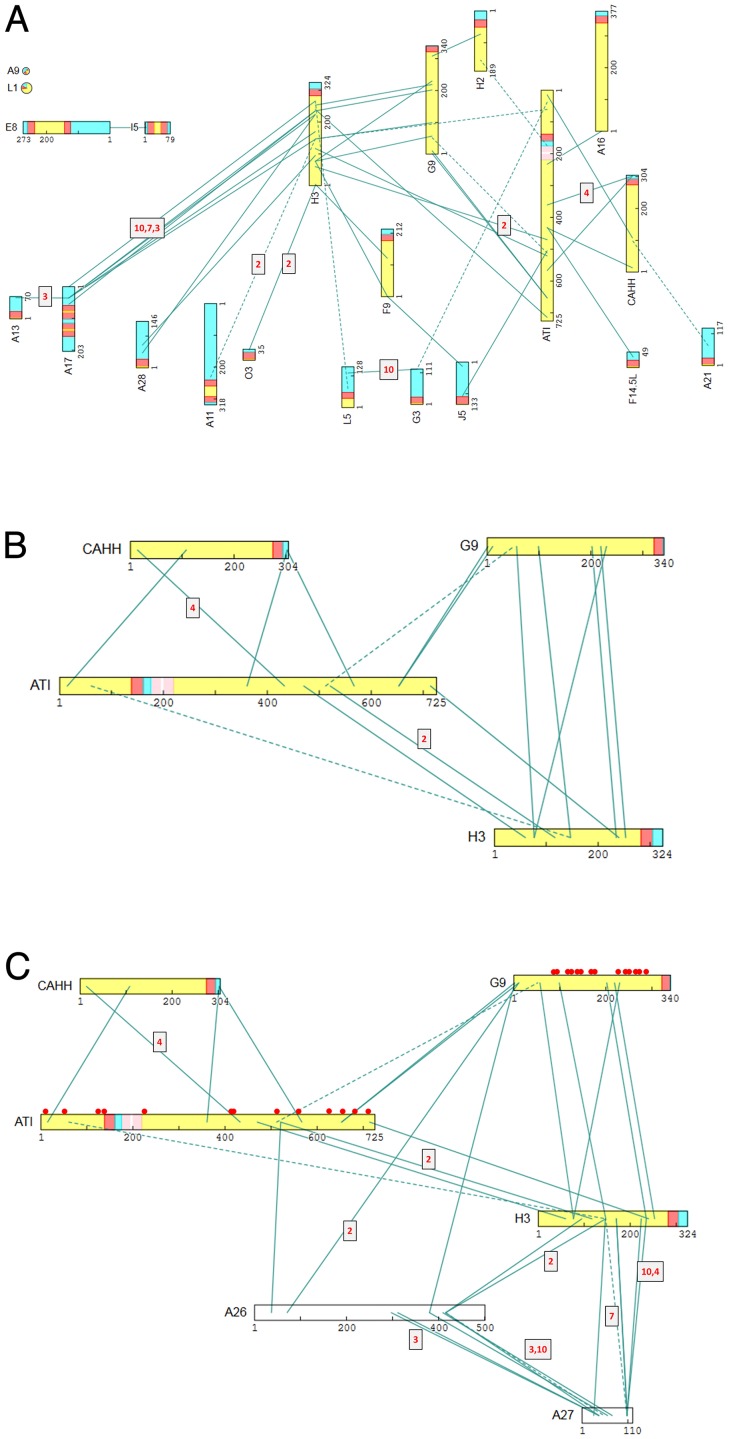
(a) All XL detected between virion TM proteins. Coloration as in Fig 8. Upper area: Proteins with XL to predicted ‘outside’ domains. Lower area: Proteins with XL primarily to predicted ‘inside’ domains. No XL were detected between protein A9 and L1 (upper left) and other members of the “Membrane” group, no XL at all were detected for A14 or I2 (not depicted) and protein A26, A27 and VENV(F13) are considered to be membrane-associated only. The remaining 21 TM proteins of the “Membrane” group are shown. ‘Minor’ predicted TM domains of ATI are colored pink. (b) ‘Major outside protein’ sub-network (proteins ATI, CAHH, G9, H3). Domain coloration as in panel A. (c) Six-member ‘attachment protein subnetwork’ (‘Major outside protein’ plus proteins A26, A27). Domains are colored as in panel A. Red circles: Positions of cysteines within the cysteine-rich proteins ATI and G9. Other details as in Fig 5.